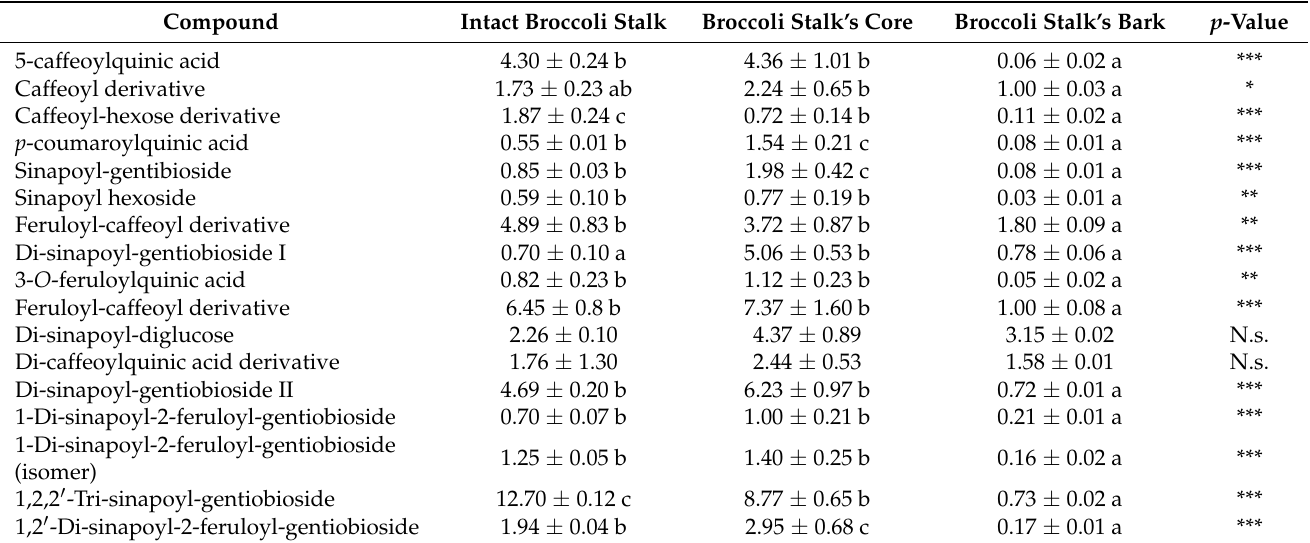
Table 1. Content (g/kg dw) of individual glucosinolates and breakdown products in lyophilized broccoli stalks fractions (intact stalks, core, and